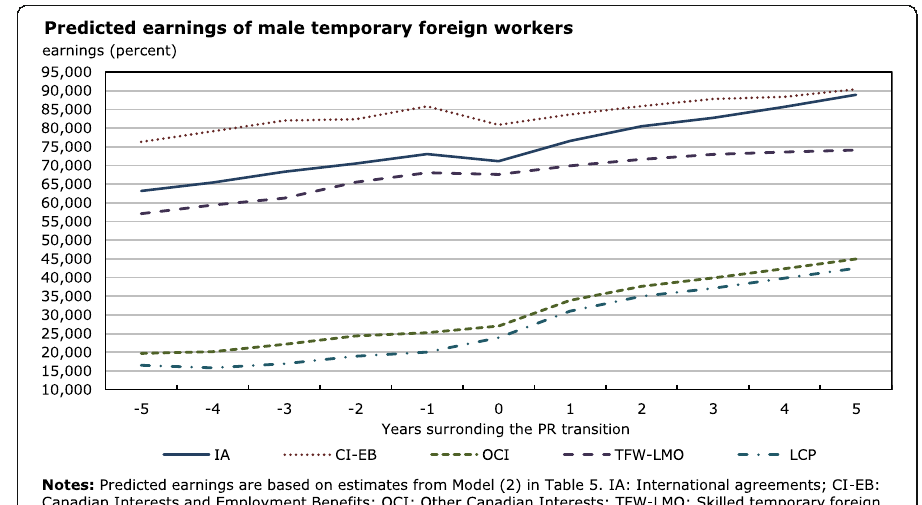
Fig. 7 Predicted earnings of male temporary foreign workers. Sources: Statistics Canada, Temporary Residents file, Immigrant Landing file and Canadian Employer-Employee Dynamics